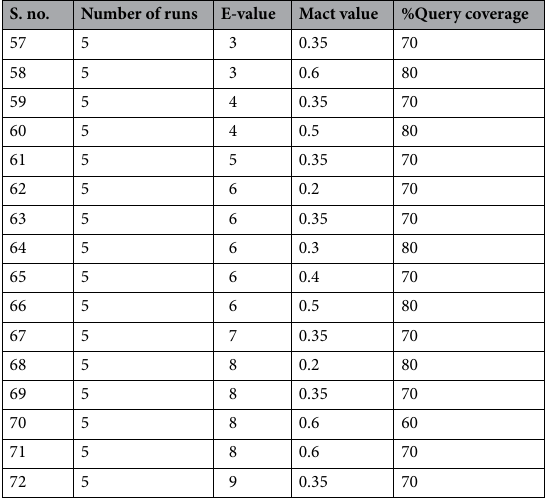
Table 2. Combination of parameters used to study the performance of HHblits.